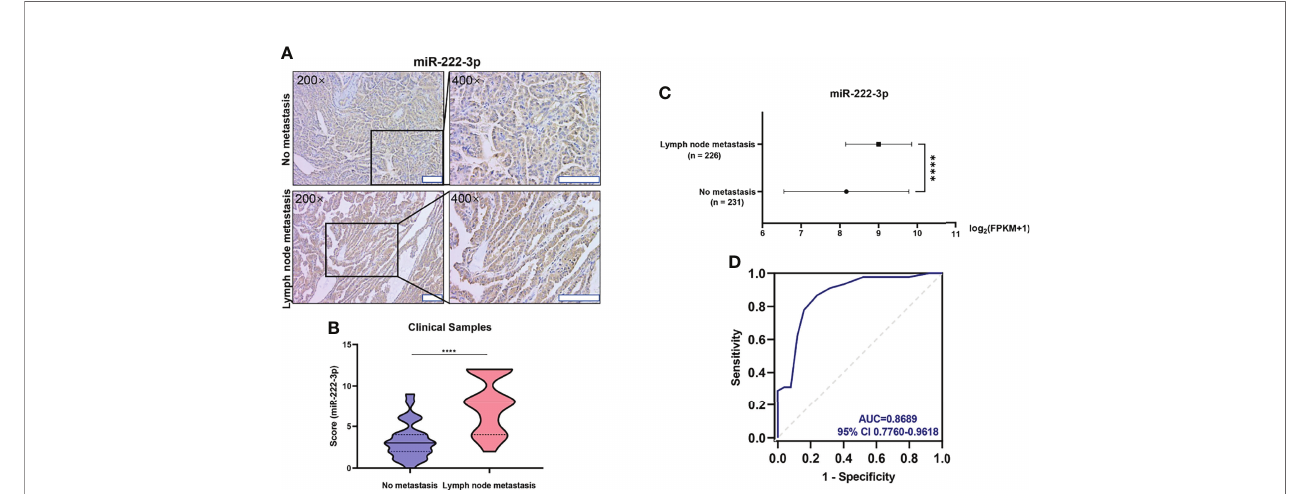
FIGURE 3 | miR-222-3p is correlated with lymph node metastasis in PTCs (A) Representative images (200×, 400×) of CISH staining of PTC lesions from clinical patients with and without lymph node metastasis. Scale bar, 100 m M. (B) Mann-Whitney t -test analysis of miR-222-3p ISH score in PTC lesions between “ No metastasis ” and “ lymph node metastasis ” group. The solid line and dotted line respectively represent median and interquartile range, ****p < 0.0001. (C) Differential analysis of miR-222-3p expression between PTCs with lymph node metastasis (n = 226) and without metastasis (n = 231). FPKM: Fragments Per Kilobase per Million, ****p < 0.0001. (D) ROC curve for the prediction of lymph node metastasis in